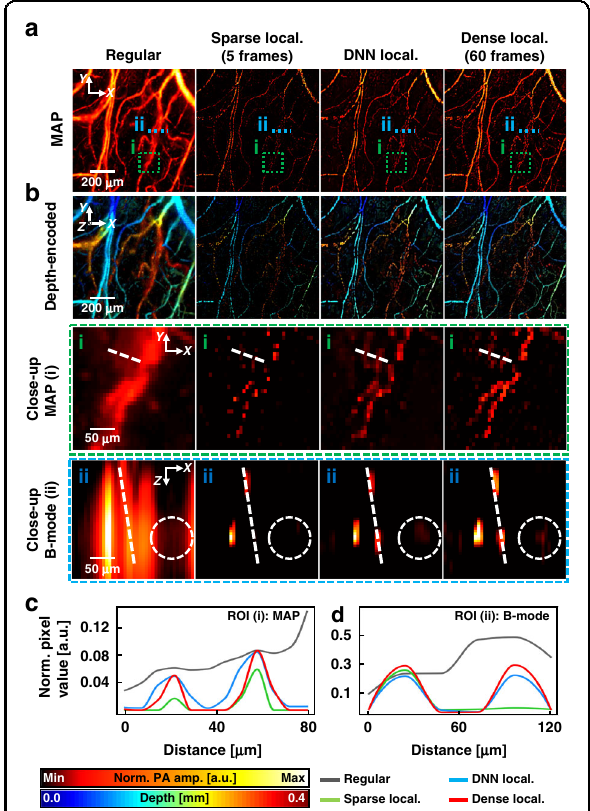
Fig. 2 Performance of 3D deep-learning localization OR-PAM. a MAP and b depth-encoded mouse ear images of regular, sparse localization, DNN localization, and dense localization OR-PAM. Frame counts of 60 and 5 are used for the dense and sparse localization- based images, respectively. Close-up views of the regions outlined by the green dashed boxes and cross-sectional B-mode images of the region highlighted by the blue dashed lines a are displayed. Pro fi les of the PA amplitude are indicated by the white dashed lines in the close- up view of c MAP and d B-mode images, respectively. OR-PAM optical- resolution photoacoustic microscopy, MAP maximum amplitude projection, PA photoacoustic, Sparse local. sparse localization-based PA image, DNN local. deep neural network localization-based PA image, Dense local. PA dense localization-based PA image, ROI region of interest, Norm. PA amp. normalized PA